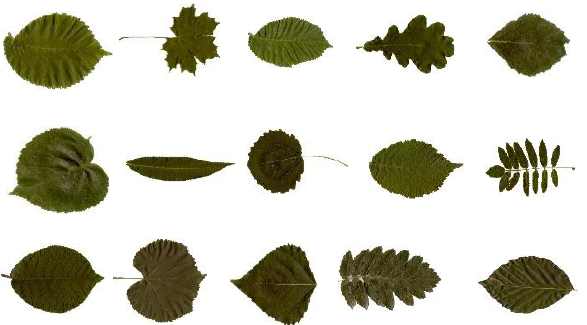
Figure 9. Standard leaf image of Swedish dataset.